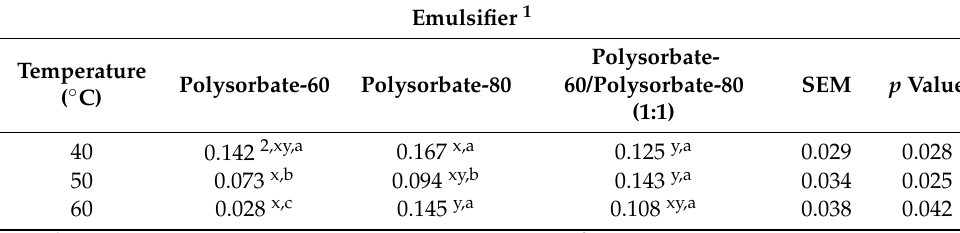
Table 4. Effects of different polysorbate emulsifiers and emulsification temperatures on emulsification